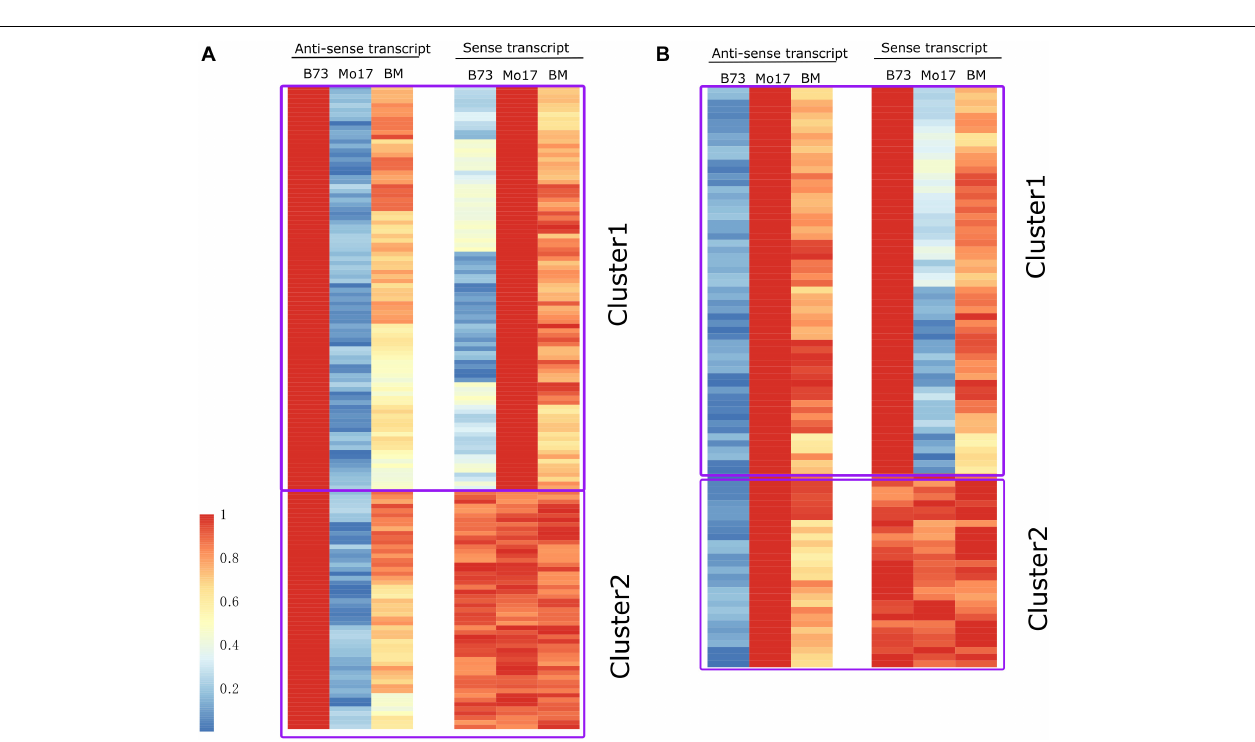
FIGURE 3 | Venn plot of detected single-parent expression of anti-sense (SPEA). (A) SPEA_B (single-parent expression of anti-sense in B73) in two tissues. (B) SPEA_M (single-parent expression of anti-sense in Mo17) in two tissues.